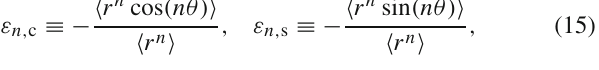
the real and imaginary parts of ε n defined in Eq. (1). In con- trast to the convention for the latter, the coefficients ε n , c / s are not necessarily